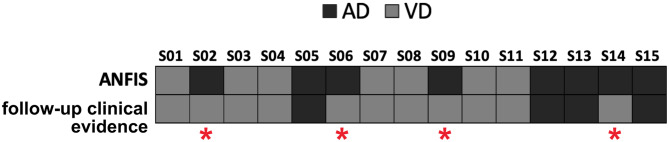
Predictions of the prevalent underlying disease (dark gray squares for AD, light gray squares for VD) on the MXD subjects performed by ANFIS using the feature pattern reported in Table 4. ANFIS correctly predicted the class for 11 out of the 15 MXD subjects (77.33% correct prediction rate). A red asterisk highlights the four subjects for whom ANFIS predicted a class that was in discordance with the clinical evidence at follow-up.